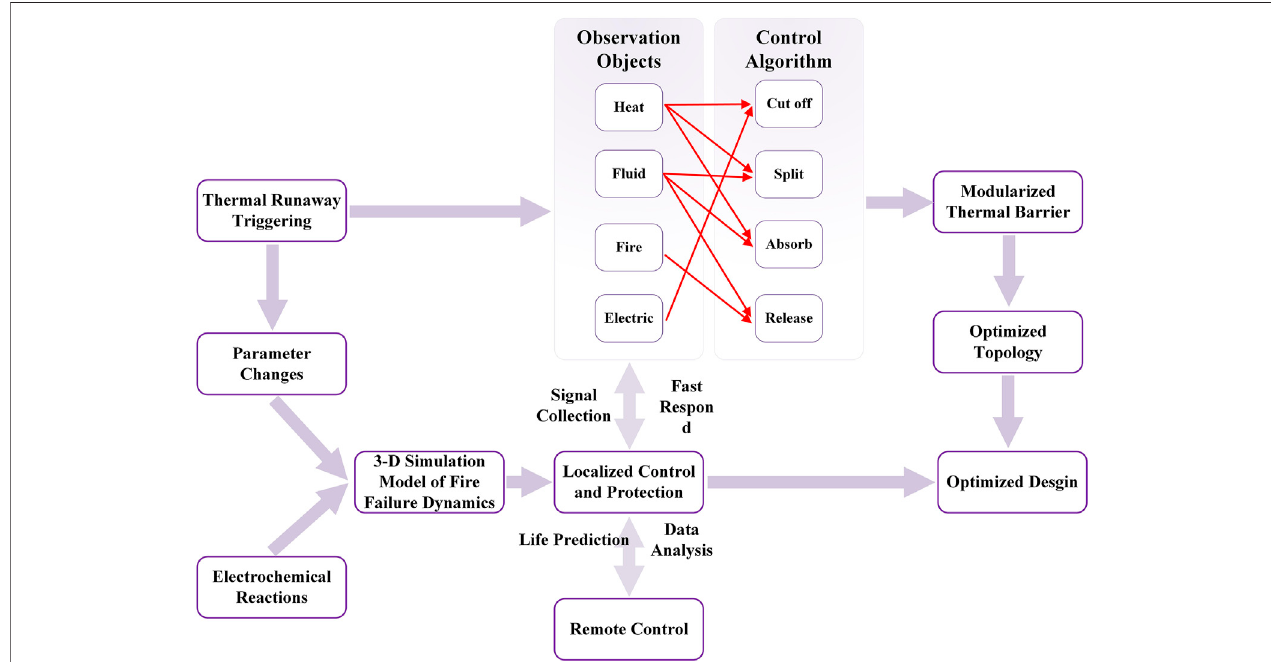
FIGURE 6 | Optimized battery module architecture with different barrier forms and